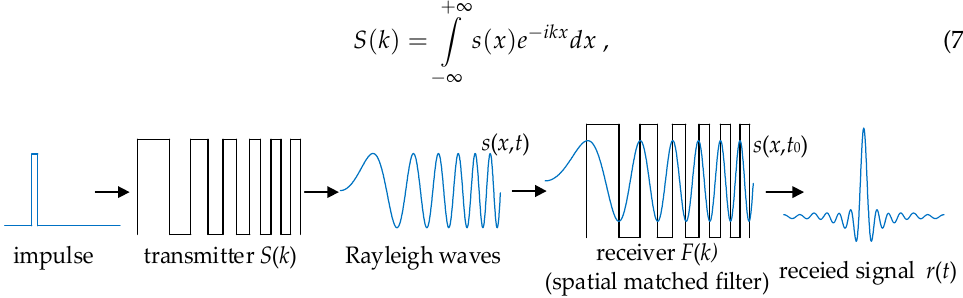
Figure 4. Schematic illustration of SPC process.